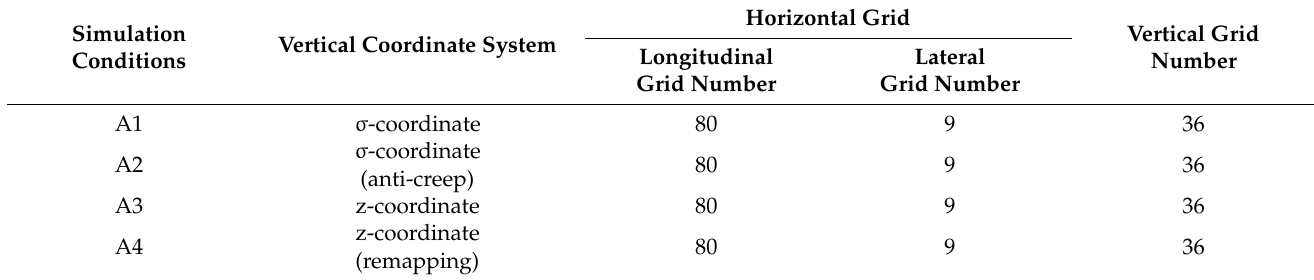
Table 1. Settings of the σ -coordinate system model and the z-coordinate system model. Table 2. Computational parameters of the three-dimensional numerical reservoir model.